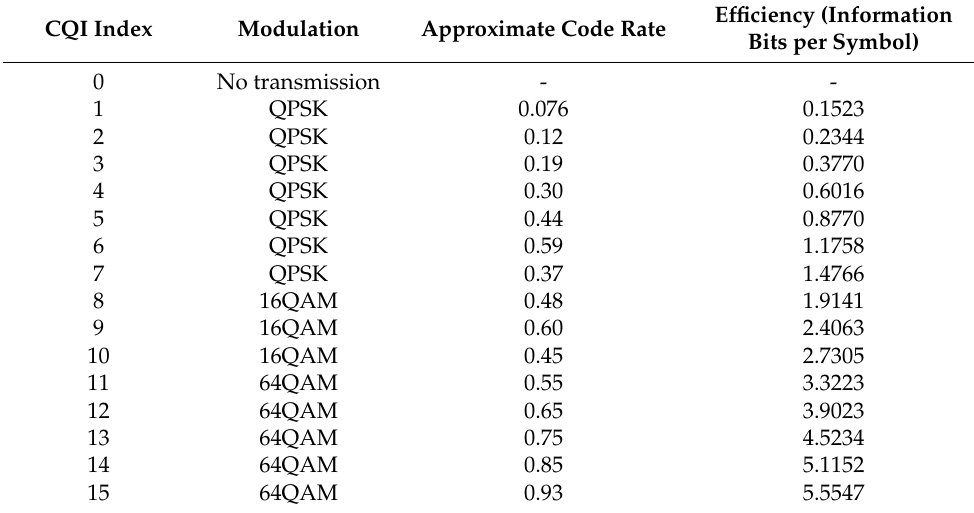
Table 2. CQI values [39].